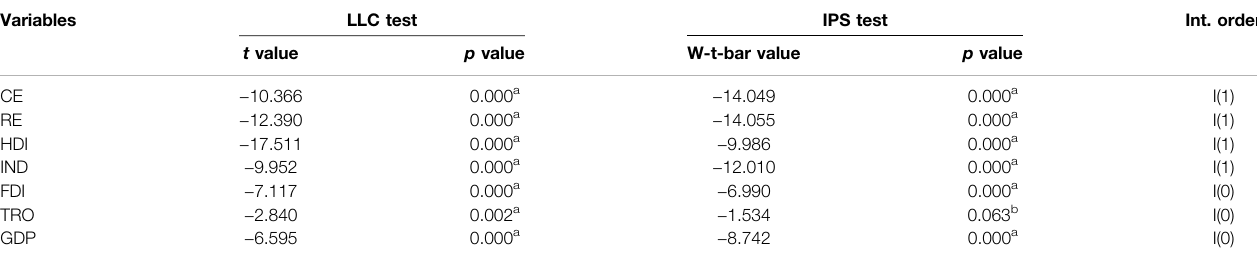
TABLE 5 | Test result of panel unit root-Lower middle-income countries. Variables